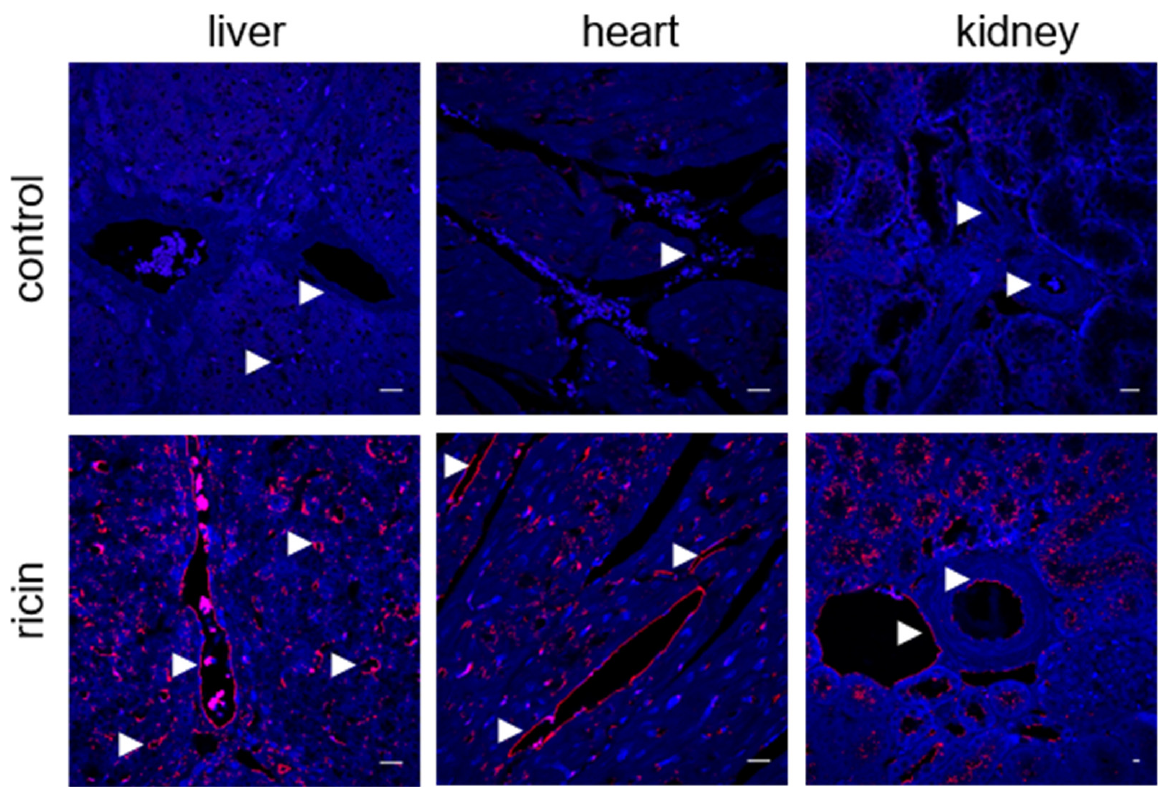
Figure 3. Ricin binding to swine tissues. Immunofluorescence (red) of the liver, heart and kidney sections before (control) or 30 min after incubation with ricin (5 µg/mL). The arrows indicate blood vessels and ricin binding. Nuclei stained by DAPI appear in blue. Scale bar: 20 µm (representative sections of n = 3 swine/group are shown).